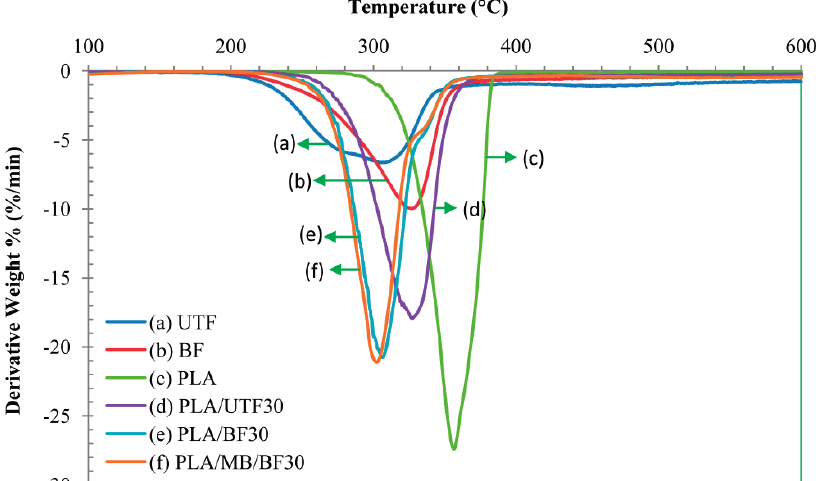
Figure 12. Derivative thermogravimetric (DTG) thermograms of neat PLA and biocomposites